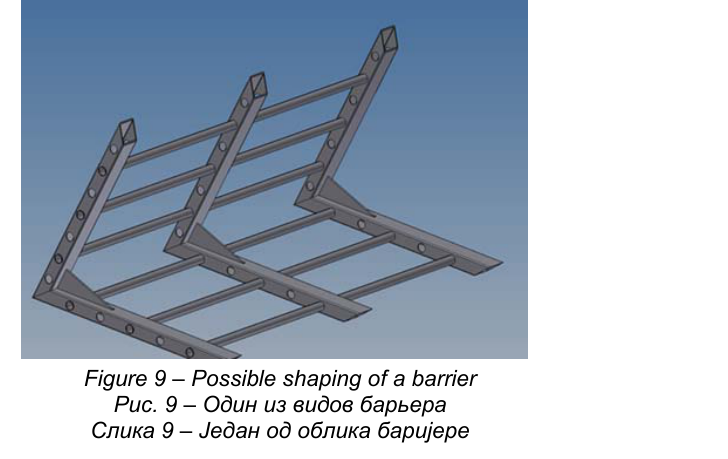
Figure 9 – Possible shaping of a barrier Рис . 9 – Один из видов барьера Слика 9 – Један од облика